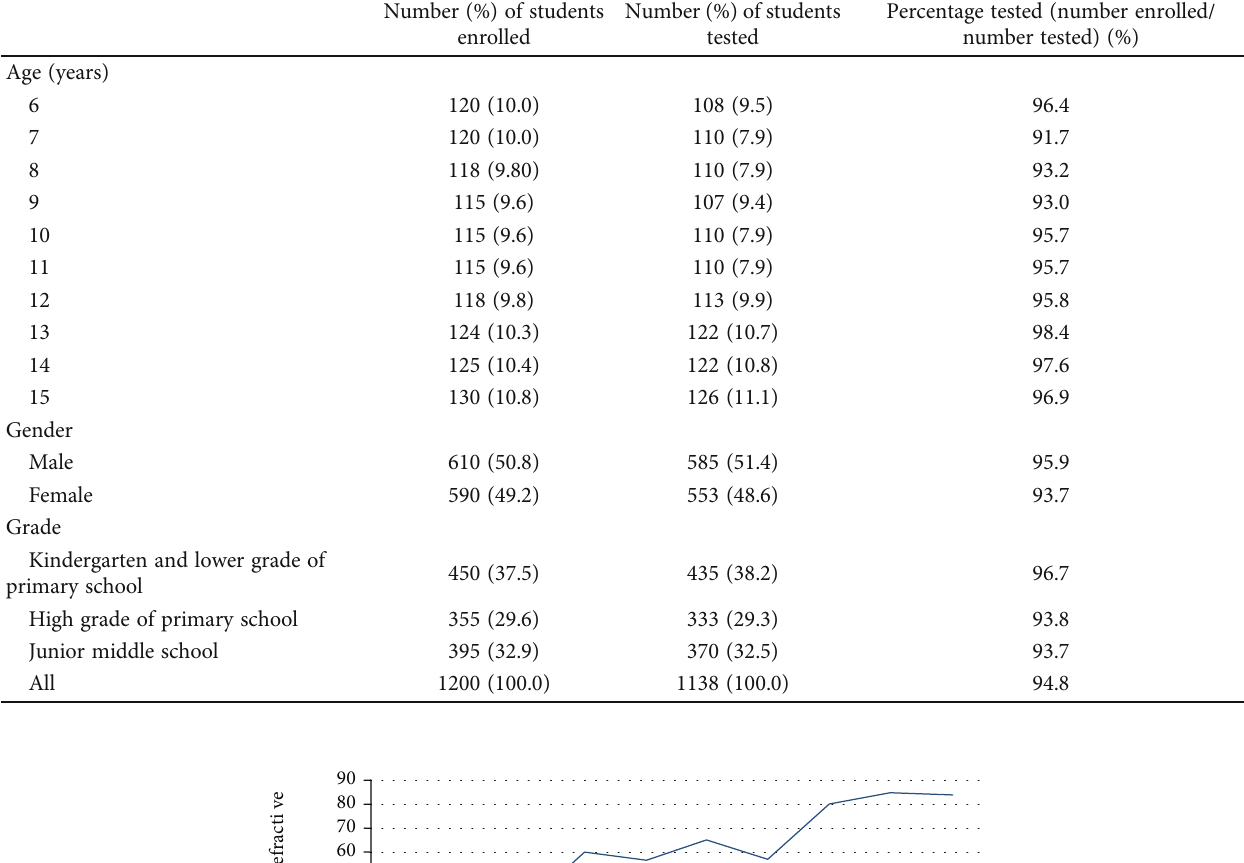
Table 1: Enrolled and tested population strati fi ed by age, gender, and grade in this study.